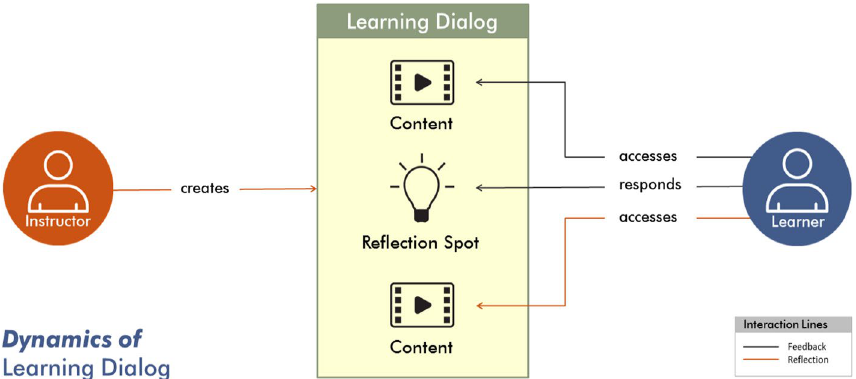
Fig. 1 Dynamics of learning dialog in the learner-centric MOOC (LCM) model (Murthy et al., 2018)